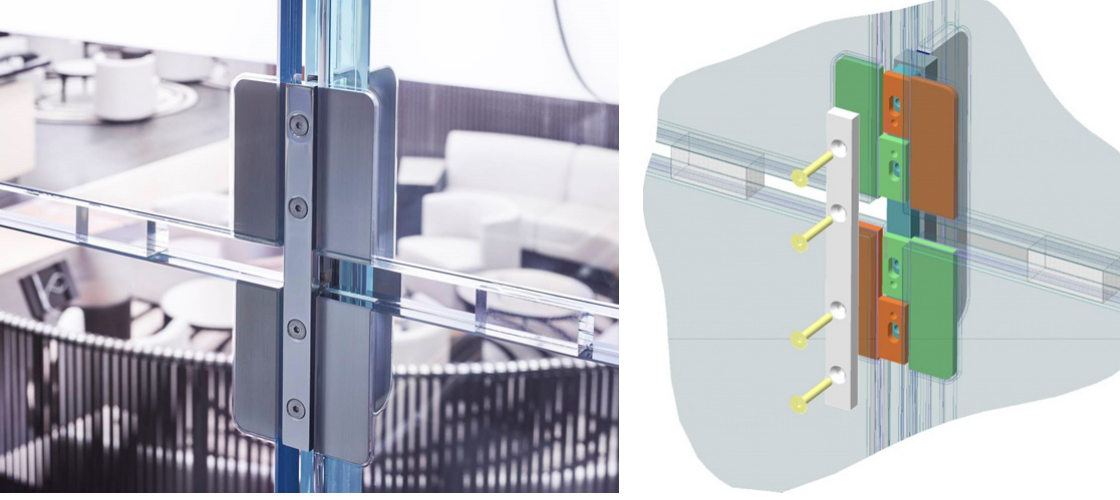
Fig. 8 Standard connection between four façade panels and a glass fin with laminated inserts.